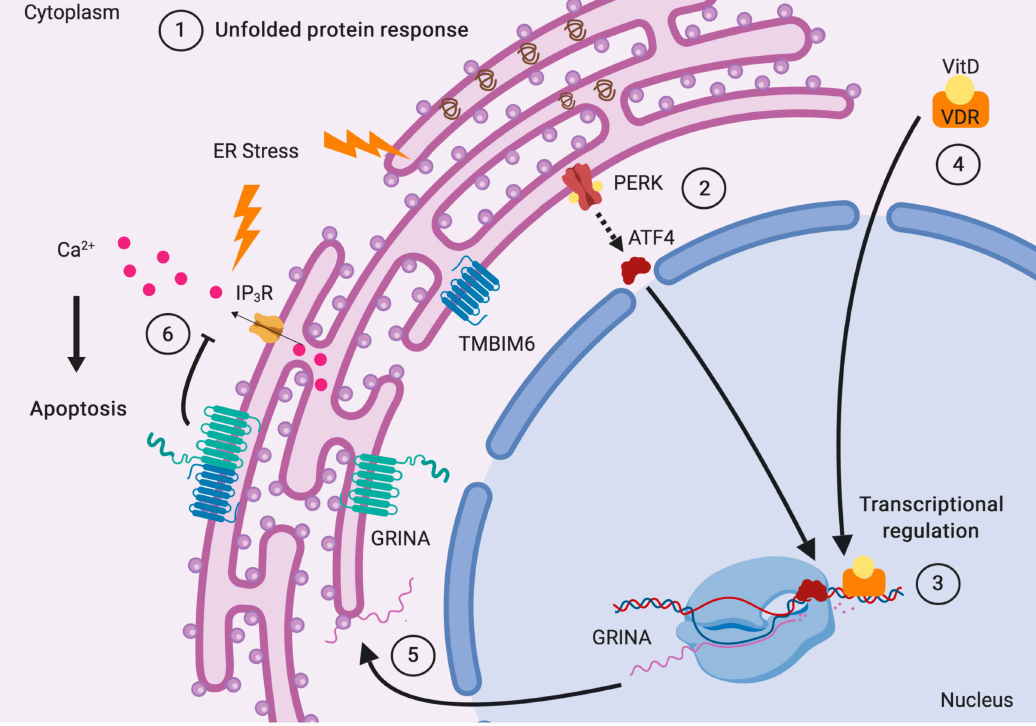
Figure 4. Transcriptional regulation of GRINA and its role in cell survival. (1) Upon ER stress the unfolded protein response is triggered. (2) The activated PERK arm allows the synthesis of the transcription factor ATF4, (3) which now can enter the nucleus and promote the transcription of GRINA. (4) Also, the vitamin D-VDR complex has been shown to enhance the expression of GRINA. (5) As a result, GRINA is synthesized (6) and able to interact with TMBIM6 to synergistically inhibit the release of Ca 2 + by inositol triphosphate receptors (IP 3 Rs) towards the cytosol, thus suppressing the intrinsic apoptosis